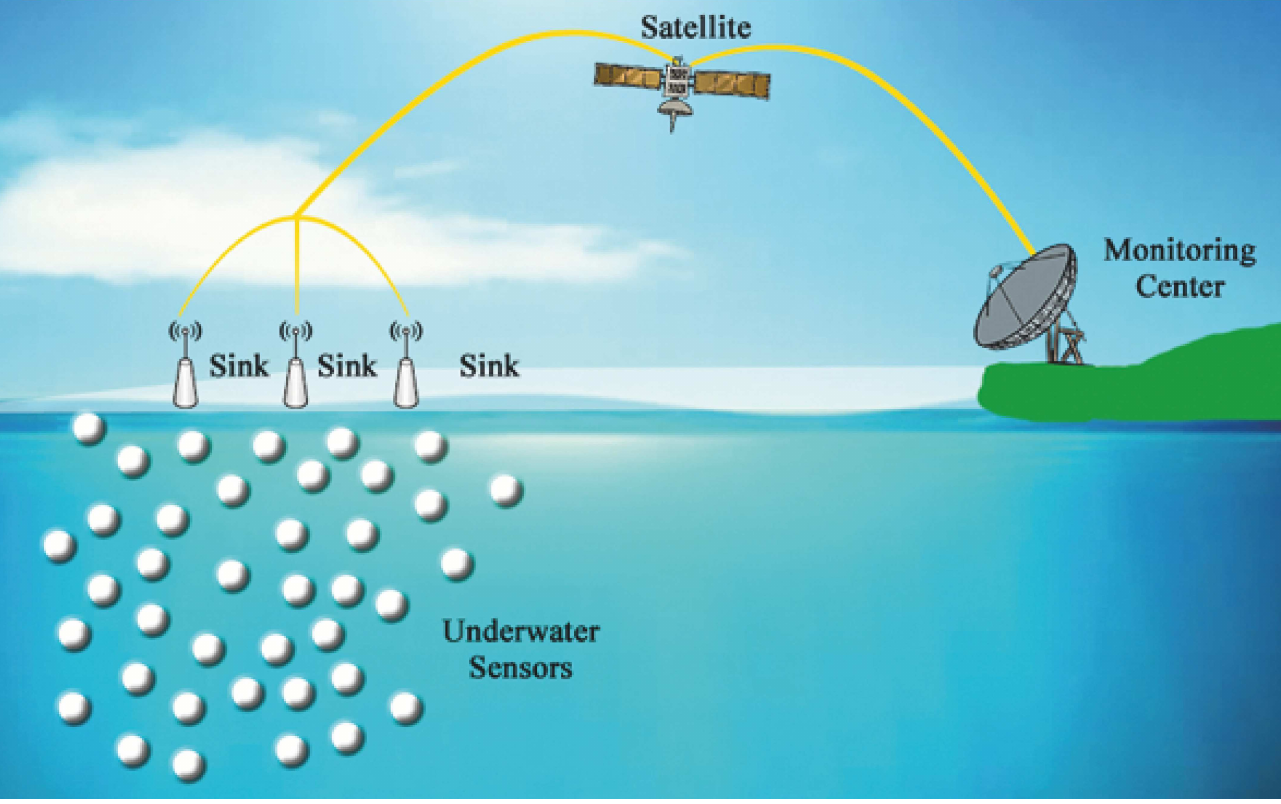
Fig 1. A typical UWSN